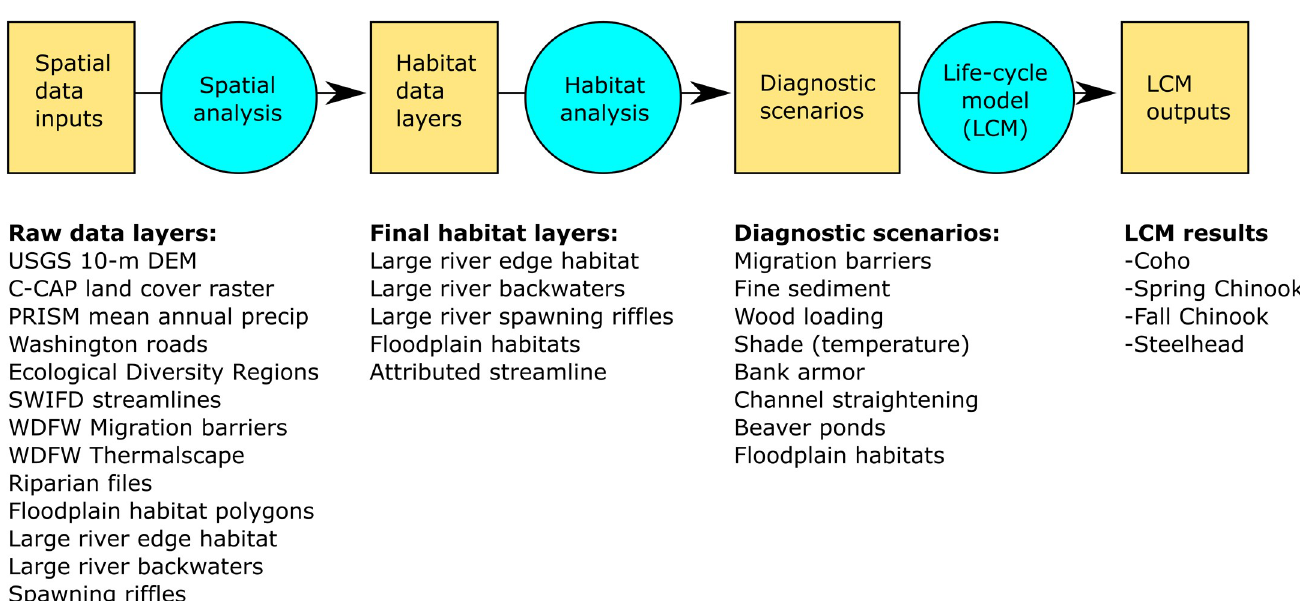
Fig 2. Model structure. The HARP model has three modules (blue circles) that translate geospatial data into habitat data layers, diagnostic habitat scenarios, and life-cycle model outputs (yellow squares).